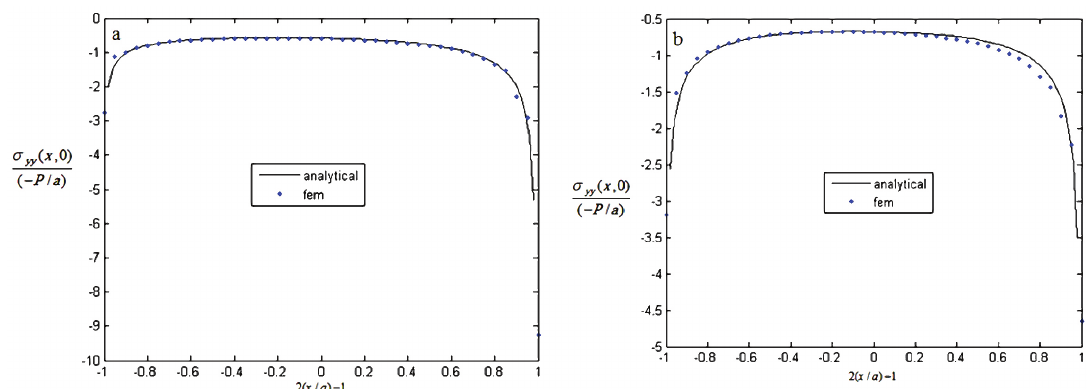
Figure 4. Comparisons of normalized contact stress distributions computed with the analytical model and ABAQUS for the case of a flat punch: (a) h =0.8, ν=0.28, a/d=1, b=0; (b) h =0.6, ν=0.28, a/d=1,